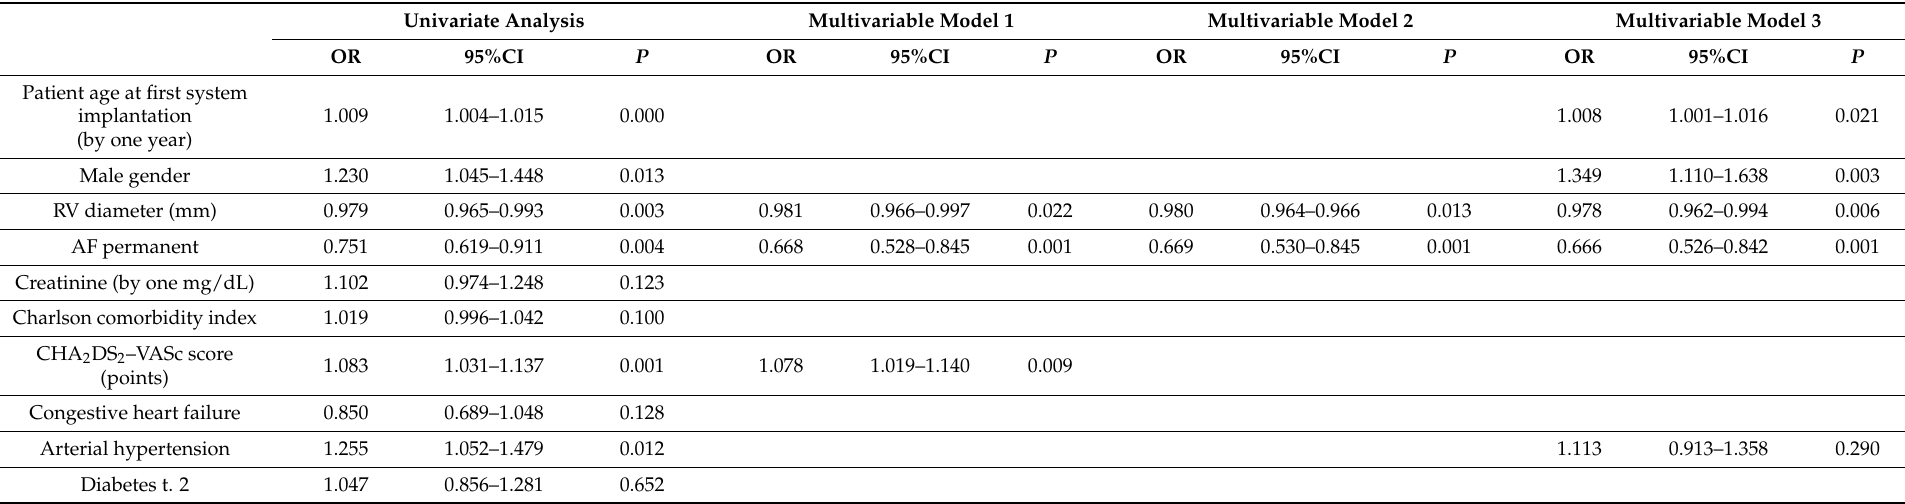
Table 4. Univariate and multivariable analysis of risk factors for lead-related venous stenosis/occlusion. Univariate